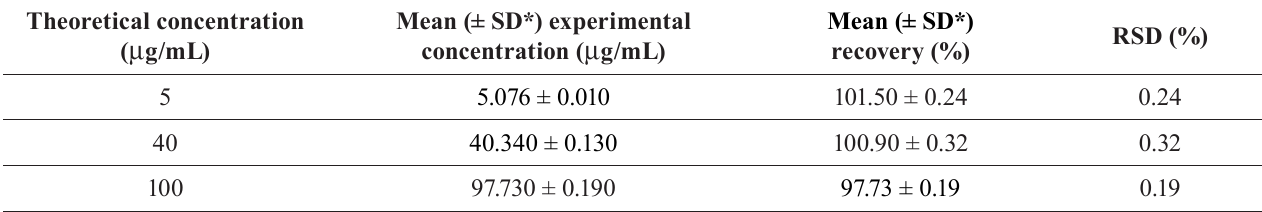
TABLE IV - Accuracy measurement at different concentrations of standard ACA solutions Theoretical concentration